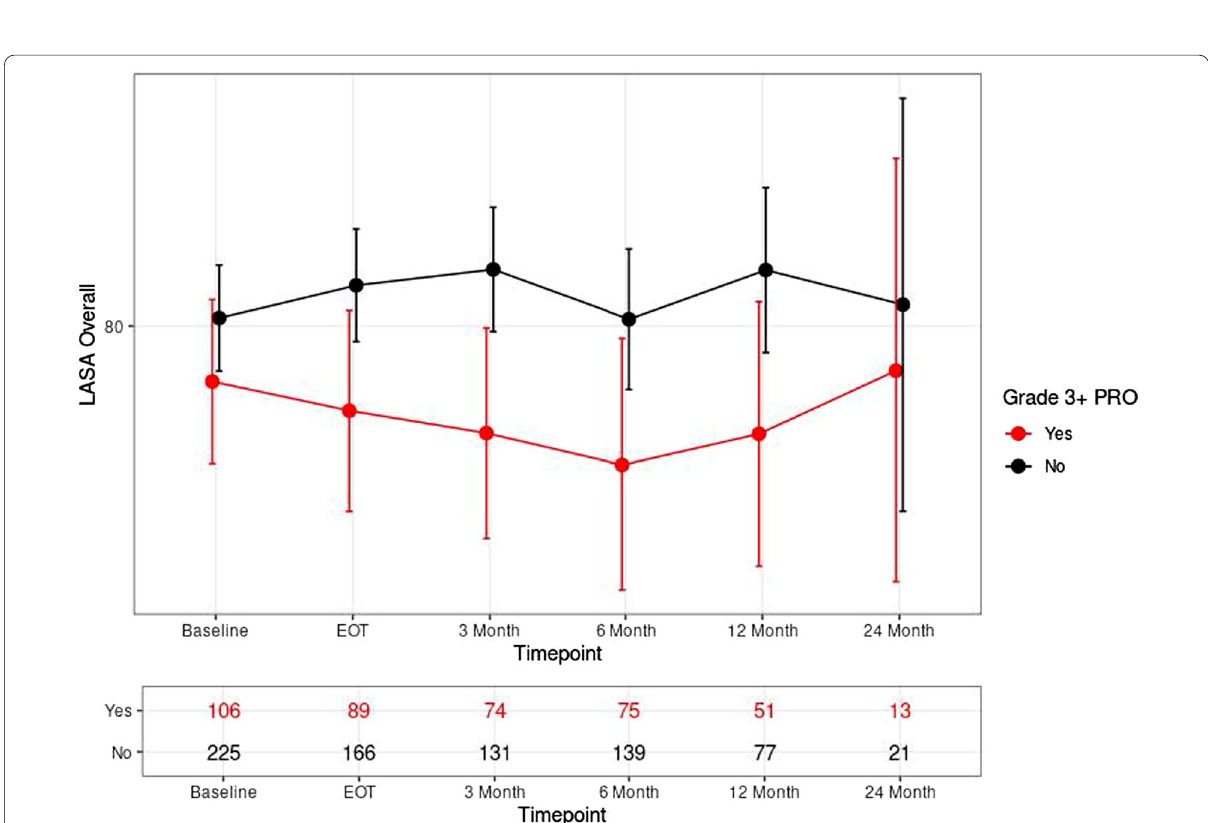
Fig. 2 Overall QOL LASA and Grade 3 PRO‑CTCAE over time. Overall average QOL LASA at each time point according to patients who ≥ reported a grade 3 (‘severe’ or worse) PRO‑CTCAE. Number of patients at each time point is found below the graph. EOT, end of treatment; PRO, ≥ patient‑reported